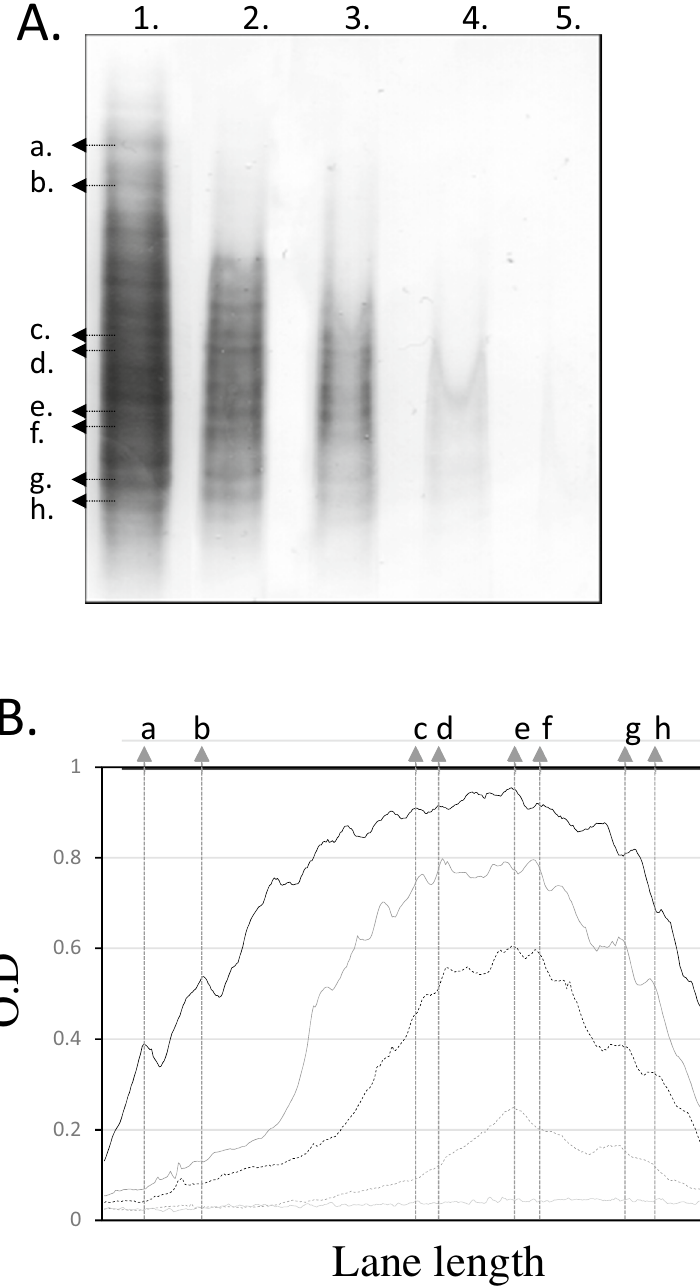
Figure 1. IEF and immunodetection of OGIgAB in a diluted serum sample from a MS patient. The quantity of IgA in lines 1–5 was: 4, 2, 1, 0.5 and 0.25 ng, respectively. ( A ) OGIgAB were observed in lines 1–4. but not in line 5. ( B ) The densitometric analysis of the band pattern in lines 1–4 showed a similar and reproducible OGIgAB pattern in all the lanes quantified. Arrows show specific bands ( A ) and its corresponding densitometric signals in the linescan analysis ( B ). Note that a single band corresponds to a density peak in the linescan analysis in most of the lanes. O.D. is represented as relative O.D., the value obtained divided by